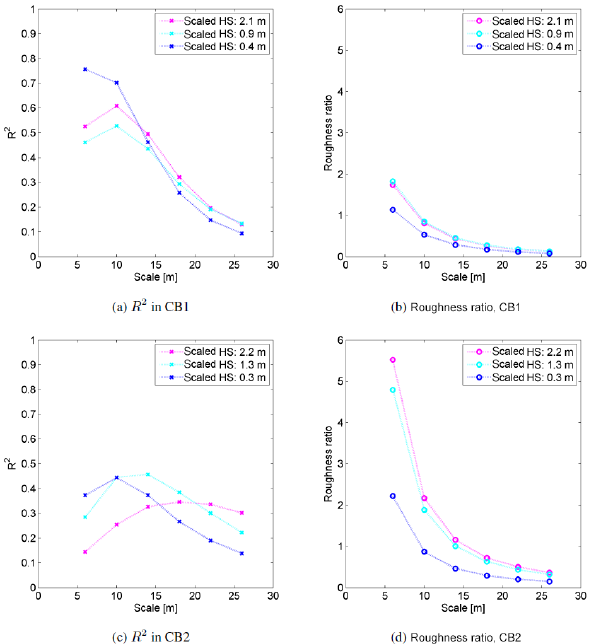
Figure 7. Correlation of multi-scale terrain roughness with win- ter terrain roughness and ratio of mean winter terrain roughness and mean summer terrain roughness in the basins CB1 (a, b) and CB2 (c, d) for three measured snow distributions. Mean snow depth in the basin is scaled with its standard deviation to account for the variability of the snow distribution, influencing its smoothing po-